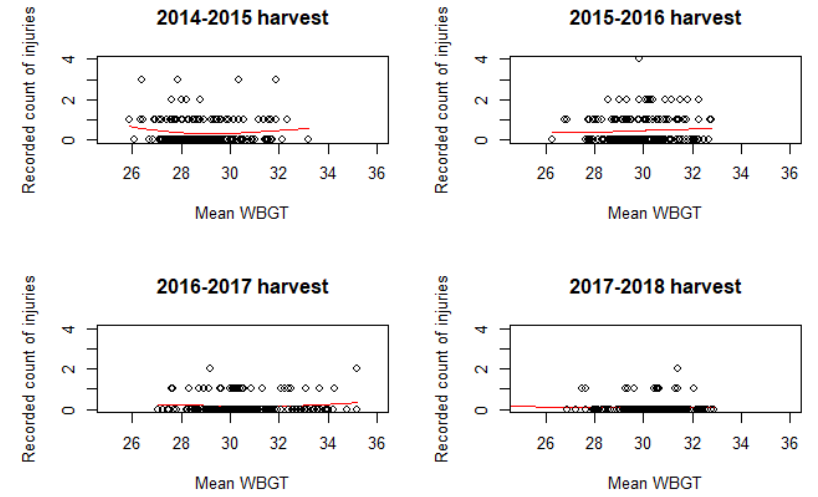
Figure 2. Correlation between daily total recorded occupational injuries reported by Southwestern Guatemalan sugarcane harvesters with daily WBGT mean temperatures. Fitted smooth spline modeled independently for 2014–2015 through 2017–2018 harvests demonstrates the non-linear relationship between occupational injury and WBGT mean .